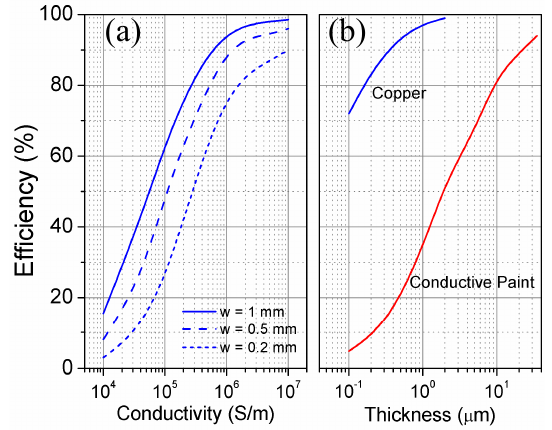
Figure 5 . Simulated radiation efficiency of the planar tag ( a ) versus conductivity for t = 35 μ m and; ( b ) versus conductor thickness for w = 1 mm. The conductive paint has a conductivity σ = 10 6 S/m [10,11].